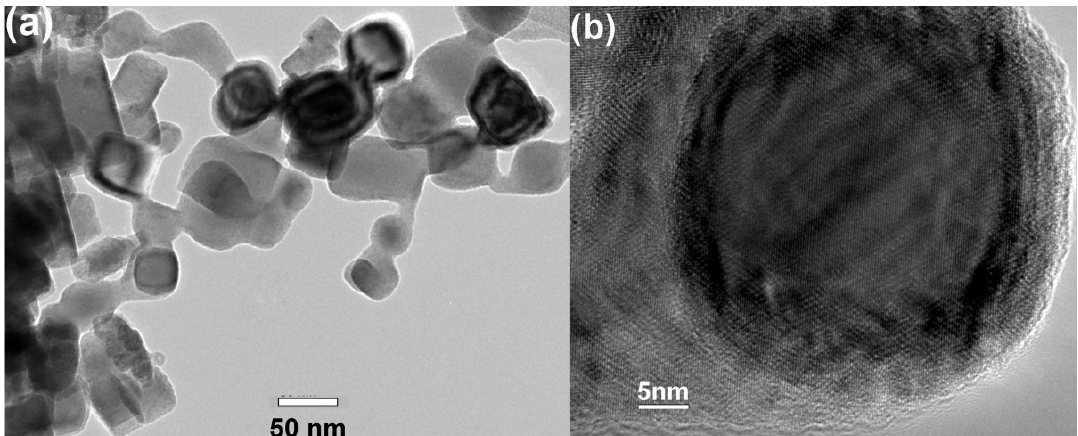
Figure 2. The low magnification ( a ) and high magnification ( b ) TEM images of the Mn–C nanoparticles. A shell/core structure of the Mn-C nanoparticles was observed.